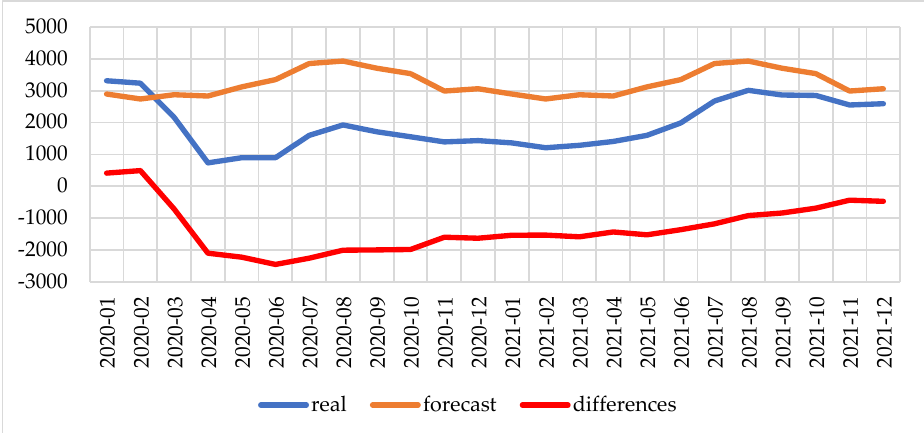
Figure 4. Comparison of the actual and forecast volumes of delivered kerosene-type jet fuel (in thousand tonnes). Source: own elaboration.